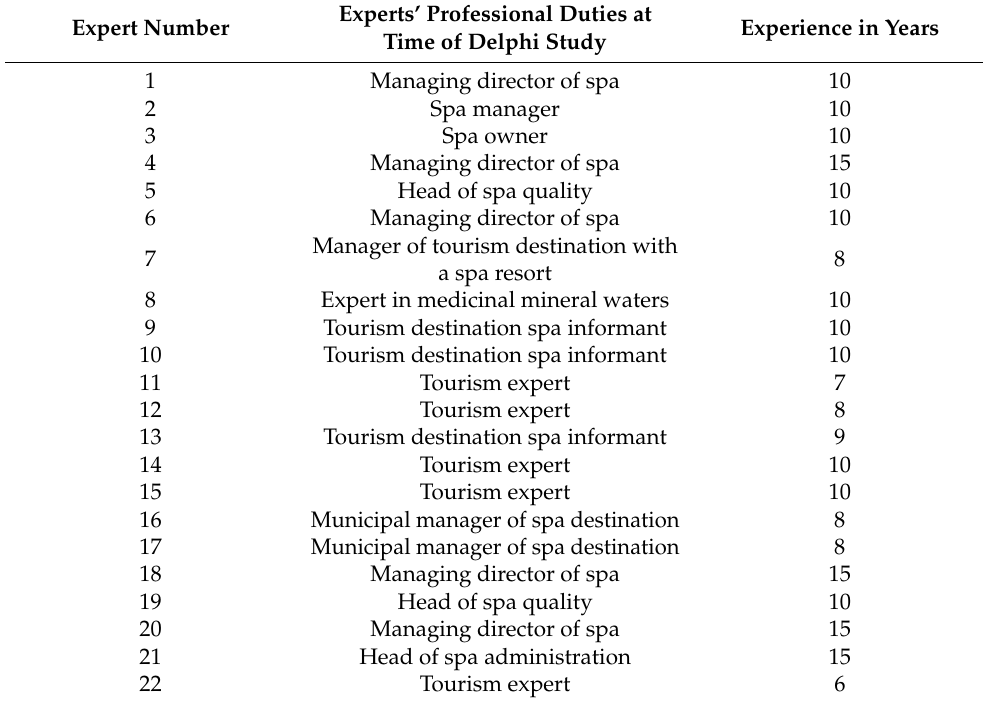
Table 3. Experts’ professional activity and experience in thermal